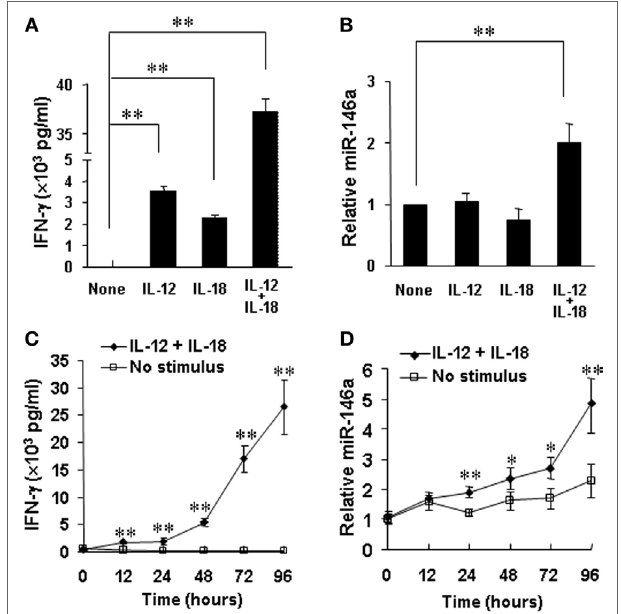
FigUre 6 | miR-146a expression in resting and IL-12 and/or IL-18- stimulated natural killer (NK) cells. Human NK cells were unstimulated or stimulated with IL-12 (10 ng/mL), IL-18 (100 ng/mL), or the combination of both for 24 h. Supernatants were harvested to be analyzed for IFN- γ production by enzyme-linked immunosorbent assay (ELISA) (a) . Cell pellets were collected for RNA preparation and cDNA synthesis, followed by assessment of miR-146a expression by qRT-PCR (B) . Human NK cells were unstimulated or co-stimulated with the combination of IL-12 (10 ng/ml) and IL-18 (100 ng/ml) for the indicated times. Supernatants were harvested to be analyzed for IFN- γ production by ELISA (c) . Cell pellets were collected and used to prepare RNA and cDNA synthesis, followed by assessment of miR-146a expression by qRT-PCR (D) . Data reported are representative of at least four experiments with similar results and are shown as mean ± SD. * p < 0.05; ** p < 0.01. Error bars represent